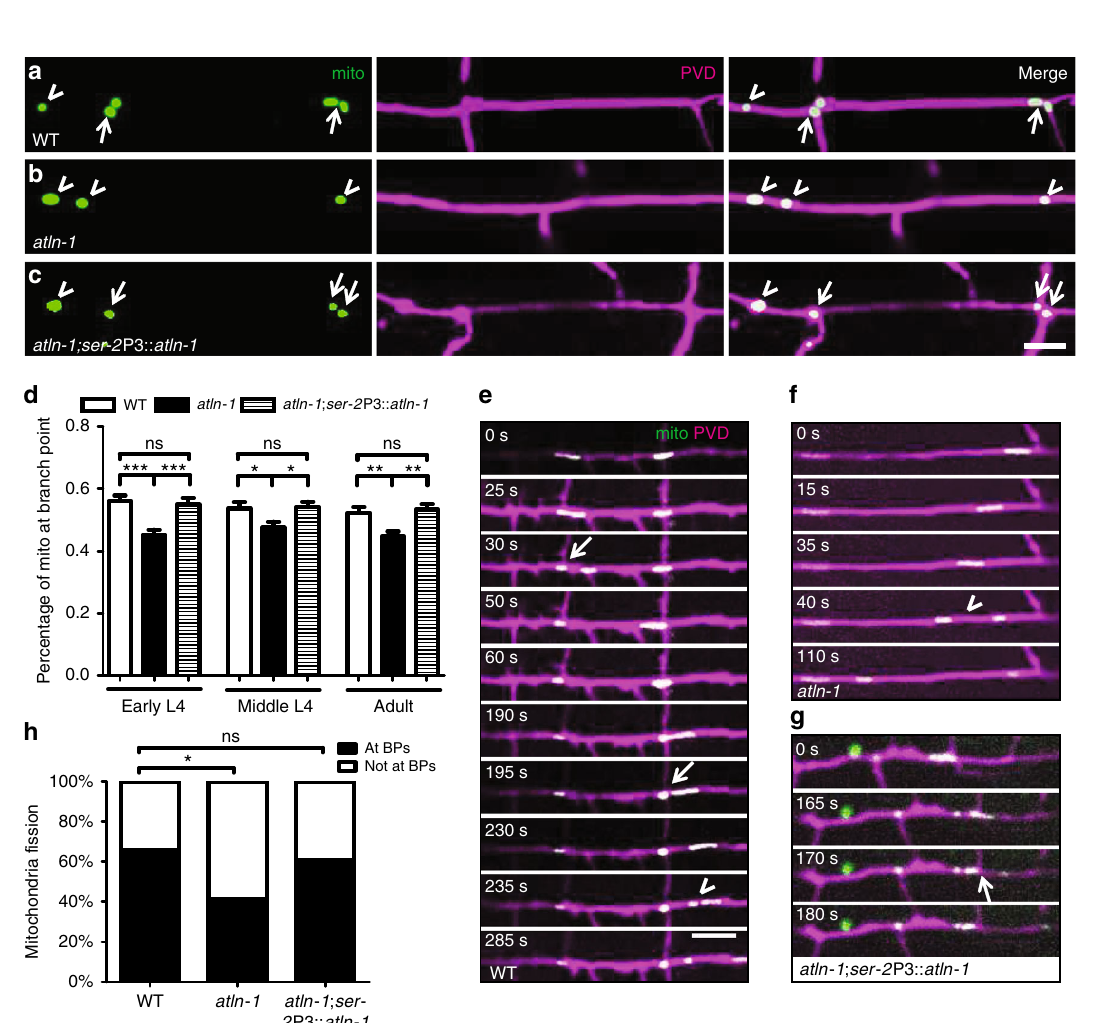
Fig. 6 ATLN-1 modulates mitochondria dynamics in dendrites. a – c Mitochondria distribution in PVD primary dendrites in WT ( a ), atln-1 ( b ) and atln-1; ser-2 Prom3:: atln-1 ( c ) worms at adult stage. Arrows indicate mitochondria at branch points. Arrowheads indicate mitochondria which are not localized at branch points. Scale bar, 5 μ m. d Quanti fi cation of the percentage of mitochondria localized at branch points. Values are mean and error bars are SEM, n > 25 for each genotype. ns, not signi fi cant; * p < 0.05; ** p < 0.01; *** p < 0.001 (Newman-Keuls multiple comparison test). e – g Time-lapse images of mitochondria fi ssion in WT ( e ), atln-1 ( f ), and atln-1; ser-2 P3:: atln-1 ( g ) worms. The arrows indicate mitochondria fi ssion events at branch points. The arrowheads indicate mitochondria fi ssion events outside of branch points. Scale bar, 10 μ m. h Quanti fi cation of mitochondria fi ssion events at and outside of branch points. n = 40 – 50. ns, not signi fi cant; * p < 0.05 (Chi-square